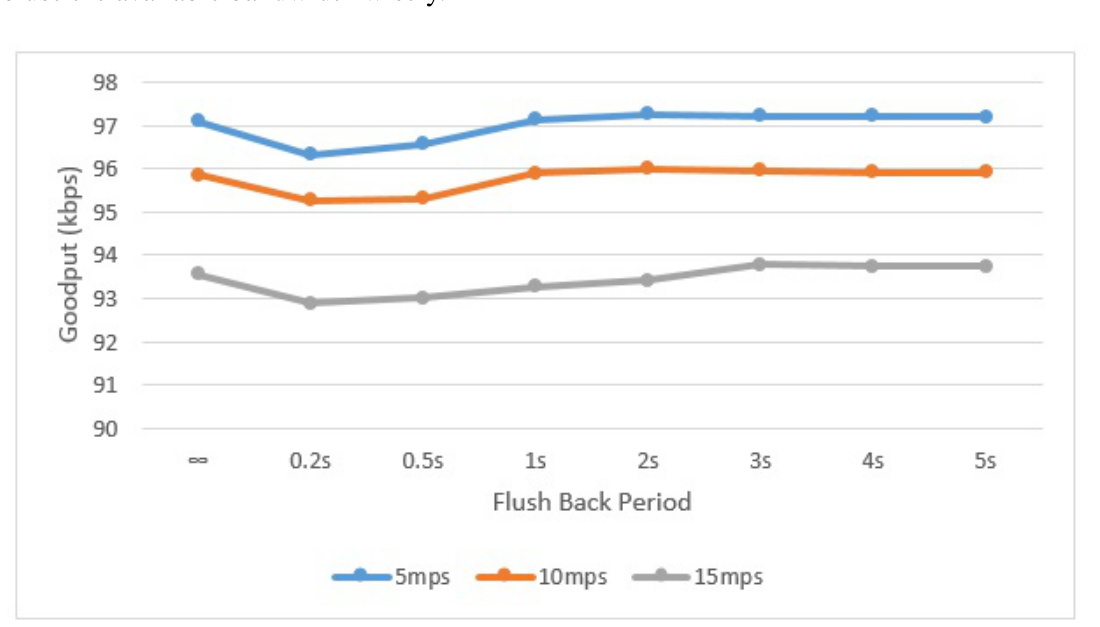
Figure 17. Network goodput for different UAV speeds and Flush Back